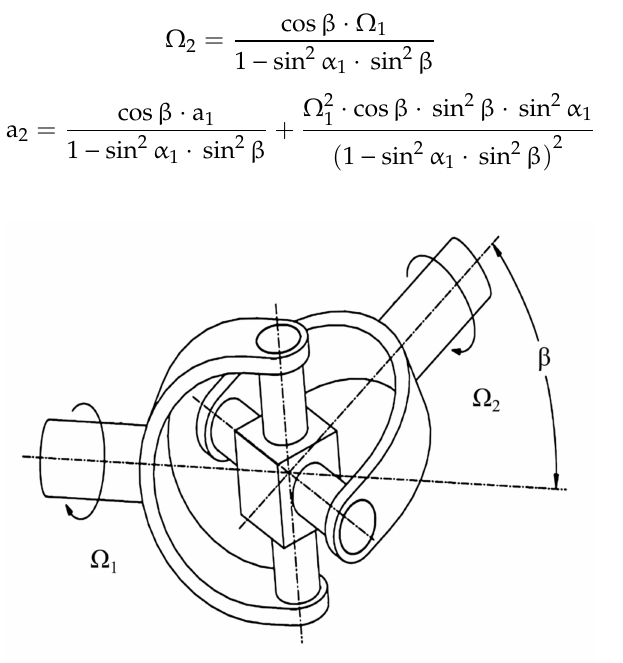
Figure 5. Schematic of Cardan shaft mechanism for rotating power